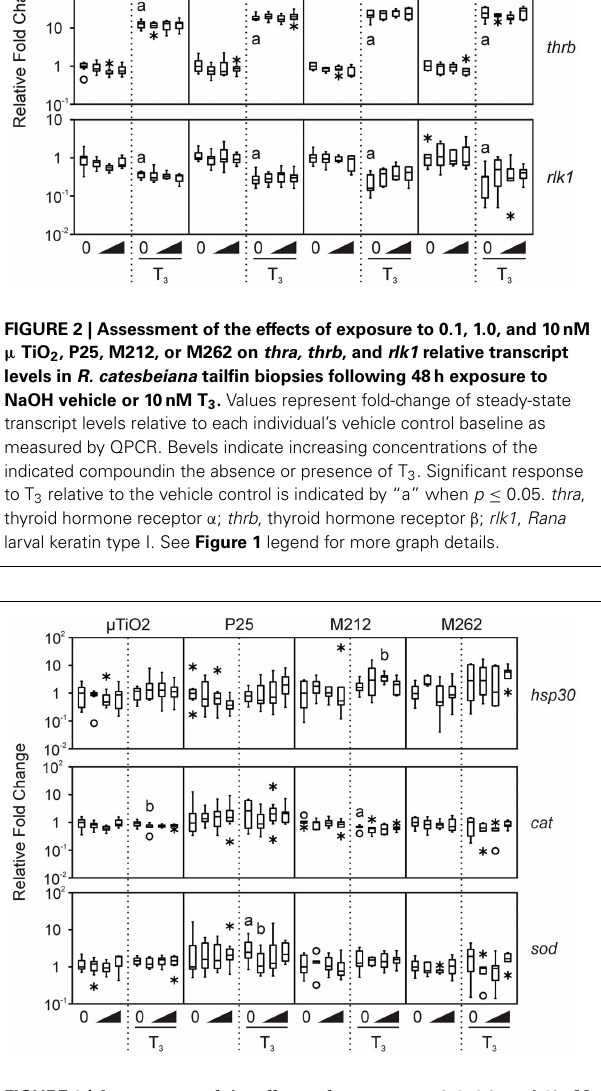
FIGURE 3 | Assessment of the effects of exposure to 0.1, 1.0, and 10nM µ TiO 2 , P25, M212, or M262 on hsp30, cat , and sod relative transcript levels in R. catesbeiana tailfin biopsies following 48h exposure to NaOH vehicle or 10nM T 3 . cat , catalase; hsp30 , heat shock protein 30; sod , superoxide dismutase. See Figures 1 , 2 legends for more graph details. Significance relative to the vehicle control for NPs alone or relative to the T 3 only control for the T 3 -treated plus NP condition is indicated by